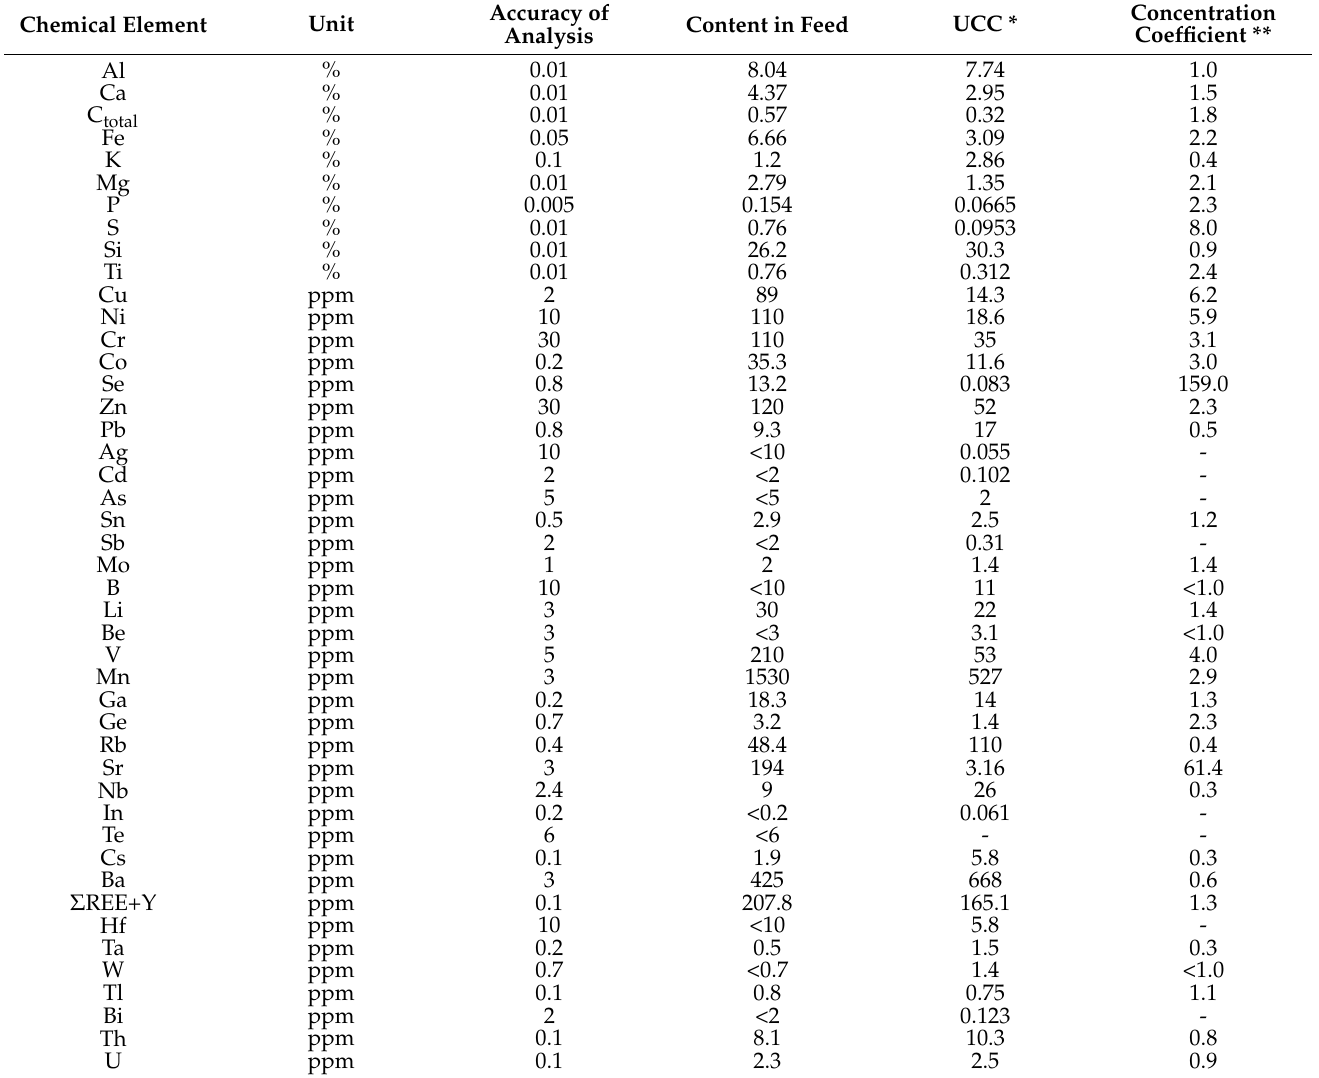
Table 2. Chemical composition of studied waste sample from Pilawa